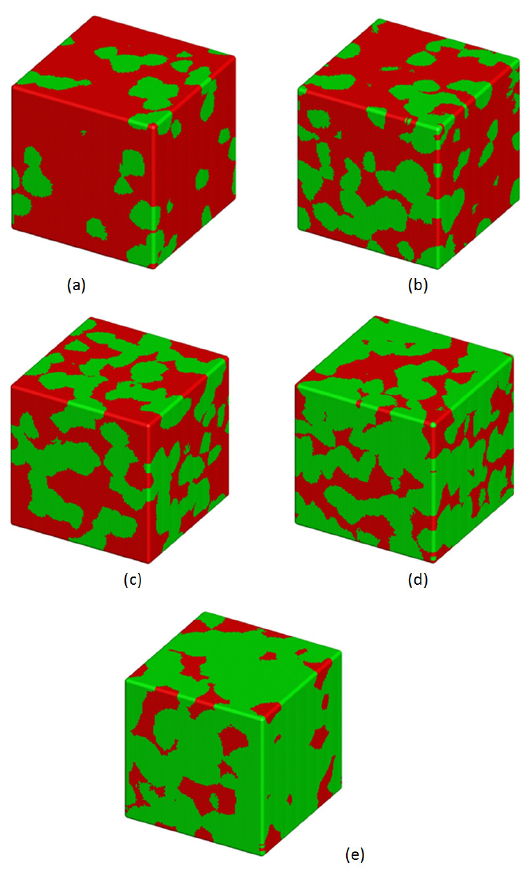
Figure 11. 3-d fully recrystallized microstructures as a function of the percentage of the total number of nuclei per unit of volume that are nuclei of the γ -fiber components. The numbers represent the percentage of γ -fiber orientations nuclei, the volume fraction of γ -fiber (“green”) and other (“red”) orientations, respectively: a)20%, 0.20, 0.80 b)40%, 0.36, 0.64 c)60%, 0.56, 0.44, d)70%, 0.66, 0.34, e)90%, 0.86,